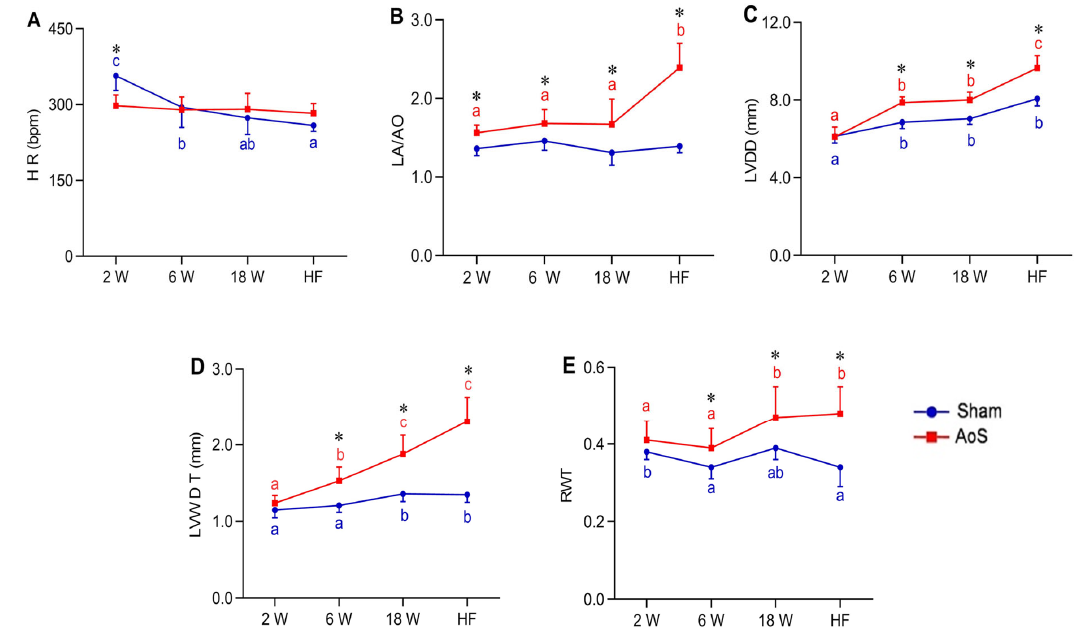
Figure 2. Heart rate and structural echocardiographic data at different euthanasia moments (2, 6, 18 weeks [W] and heart failure [HF]). Sham: operated control (blue); AoS: supravalvar aortic stenosis (red). ( A ) HR: heart rate; ( B ) LA/AO: left atrial diameter (LA) to aortic diameter (AO) ratio; ( C ) LVDD: left ventricle (LV) diastolic diameter; ( D ) LVWDT: LV posterior wall diastolic thickness; ( E ) RWT: LV relative wall thickness. Data are expressed as mean ± SD and analyzed by ANOVA and Tukey. p < 0.05. * AoS vs. respective Sham. Distinct letters signify statistical difference between moments ( n = 12–18 animals for each group).